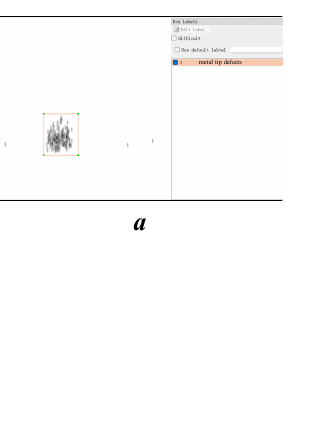
Table 3. Experimental environment configuration. Project